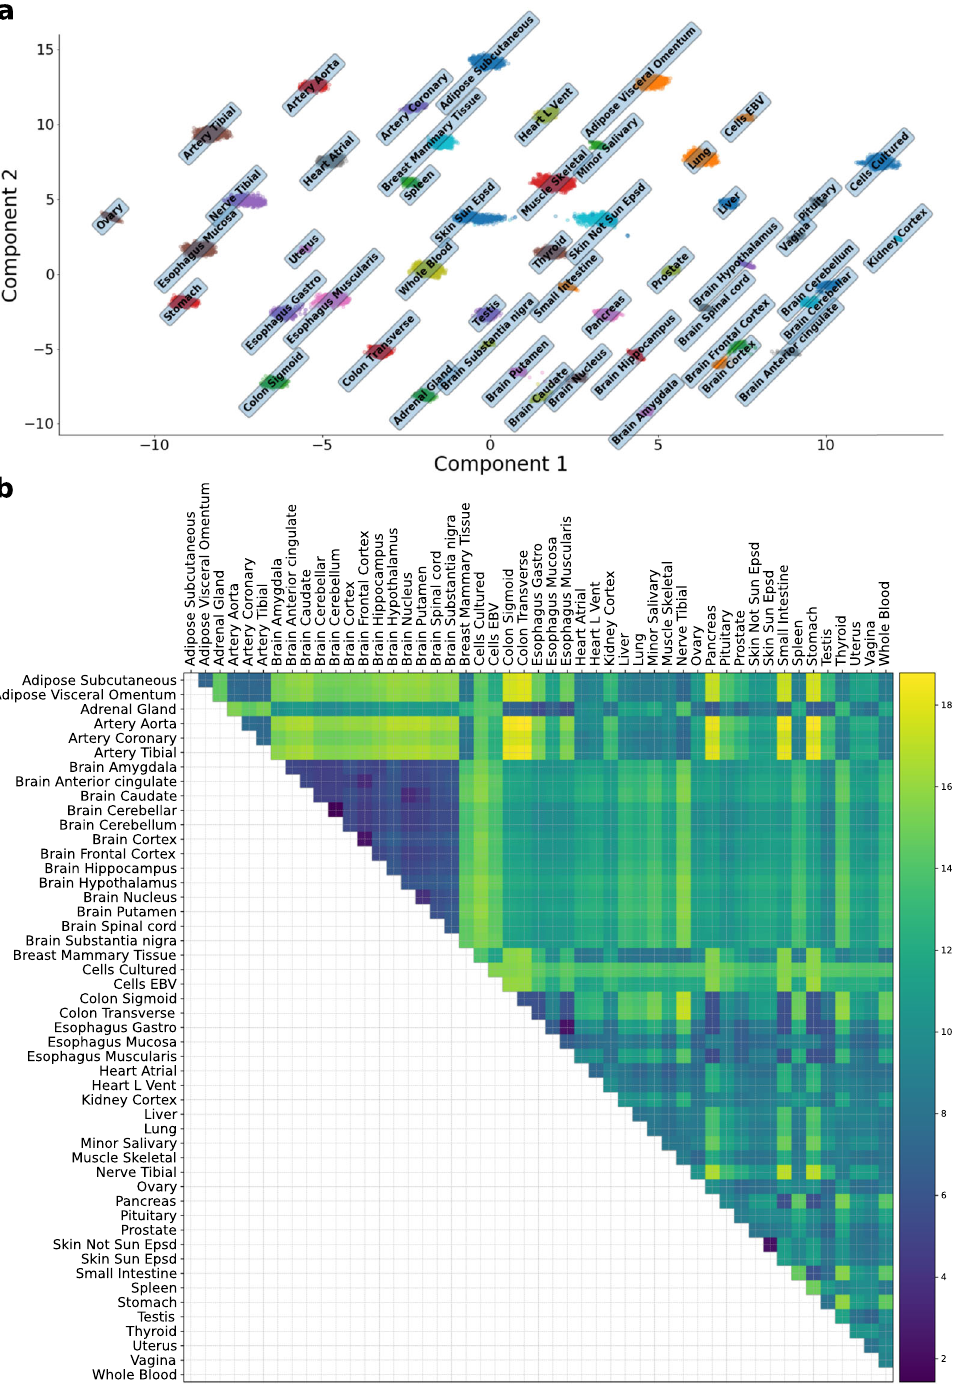
Fig. 4 Lower-dimensional UMAP representation of the transcriptome data restricted to the communities and conservation of global structure. a UMAP generates embedded structures through a low-dimensional projection of the submatrix consisting of only the genes that belong to a community in at least one tissue ( n = 3259). This subset of genes (17.7% of total) contains suf fi cient information to recover the tissue clusters. In addition, known relationships between tissues, based on organ membership and, separately, on shared function, are re fl ected in the UMAP projection. b Using bootstrapped manifolds (see “ Methods ” section), we estimated the persistence of the global structure and pairwise relationships across tissue clusters. Here, we show the upper-triangular matrix of the average pairwise distances across the bootstrapped manifolds. We found consistent clustering of known related tissues, including the 13 brain regions, the colonic and esophageal tissues, and various artery tissues. Additional patterns were observed. For example, as re fl ected in the heatmap, we found a highly correlated relationship, i.e., high "clustering conservation coef fi cient'' ( C ð i (cid:2) 0 : 62 , p = 3.4 × 10 − 5 ) (see “ Methods ” section), of the two skin 0 ; i 1 Þ tissues to all the other